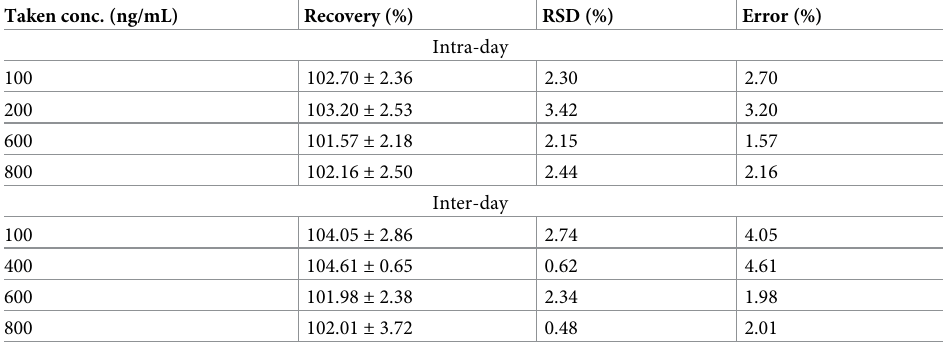
Table 3. Accuracy and precision of the proposed micellar-enhanced spectrofluorimetric method for determina- tion of LAP. Taken conc. (ng/mL)